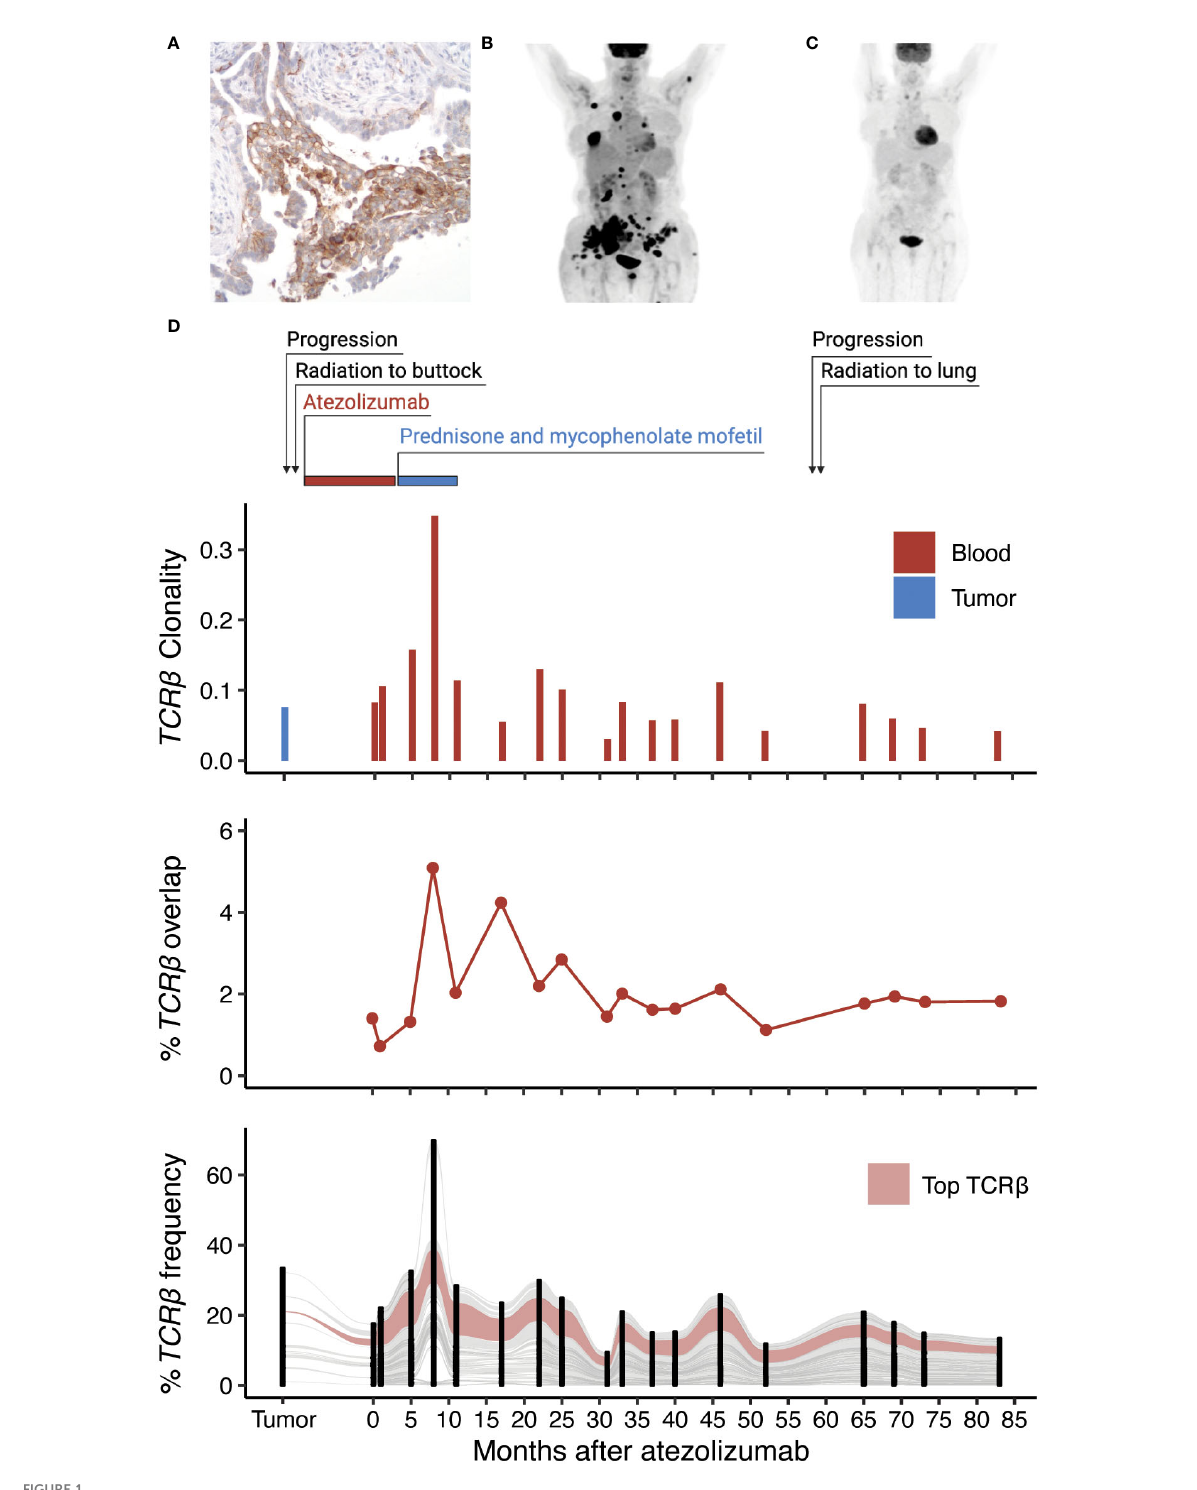
FIGURE 1 Identi fi cation of an expanded T cell clone following radiation and anti-PD-L1 therapy. (A) Expression of PD-L1 within the metastatic tumor biopsy by immunohistochemistry. (B) PET scan of the patient before and (C) one year of anti-PD-L1 therapy. (D) Treatment timeline of the patient in relation to TCR b clonality (inverted Shannon entropy), percent overlap of all TCR b sequences detected in the tumor and the blood, and an alluvial plot tracking the frequency of the top 100 TCR b sequences shared by at least 2 samples across all collection time